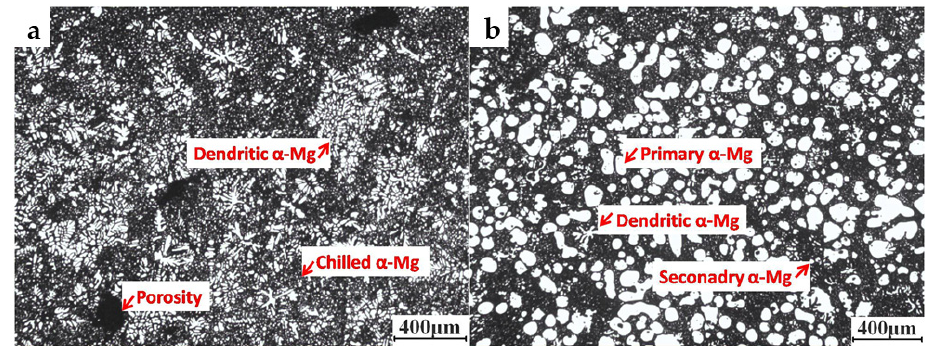
Figure 9. Microstructure of AM60 produced by conventional liquid die casting ( a ) and SIRD ( b